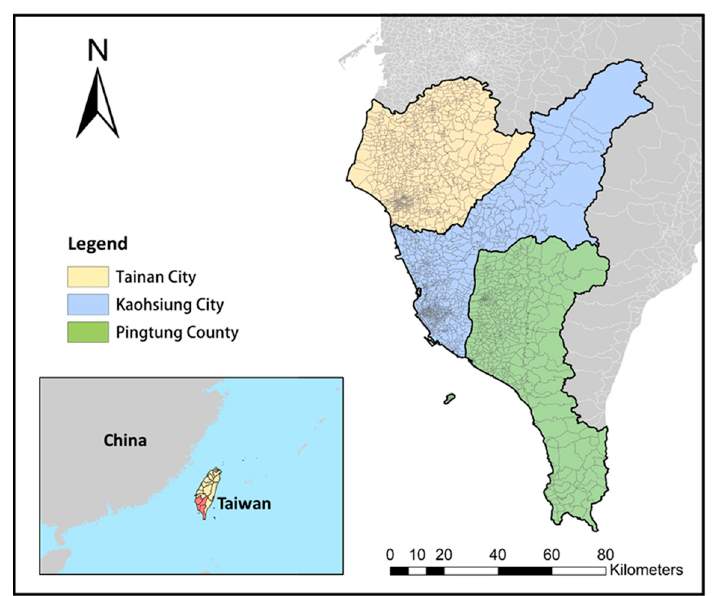
Figure 1. Study area.